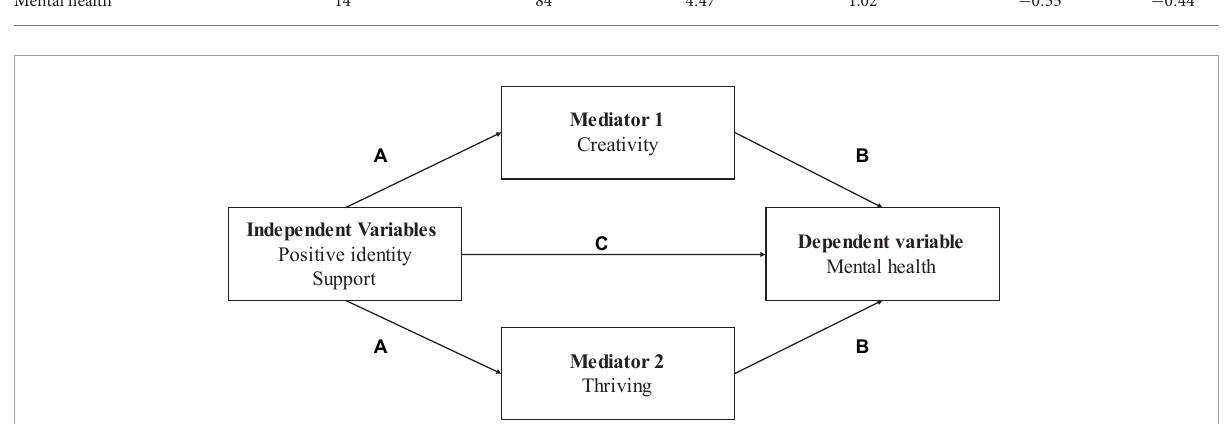
FIGURE1 Hypothesized relationships among subscales of developmental assets, creativity, thriving, and mental health.